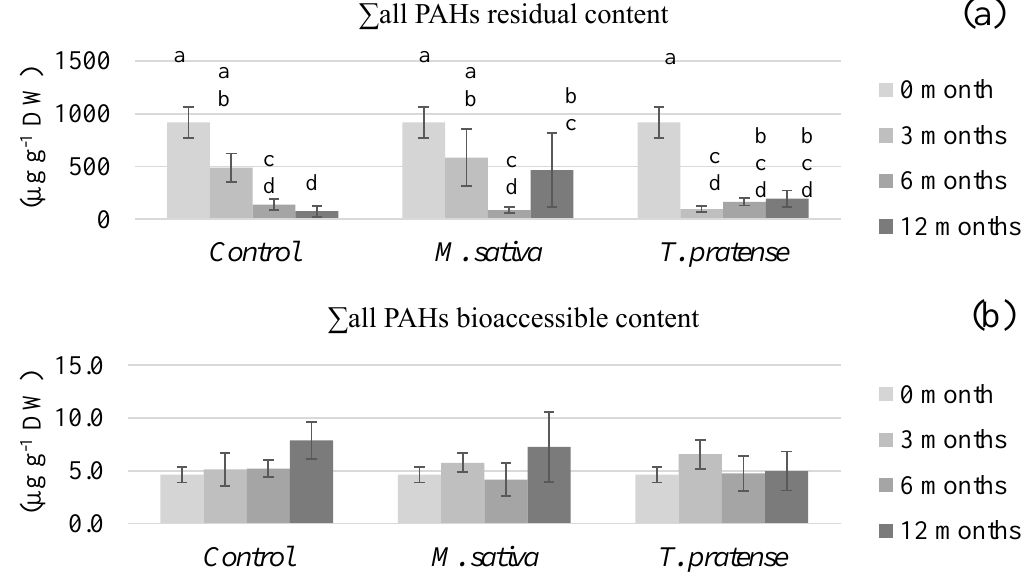
(cid:80) Figure 6. The total PAHs’ ( all) ( a ) residual and ( b ) bioaccessible contents of soils planted with Figure 6. The total PAHs’ (∑all) ( a ) residual and ( b ) bioaccessible contents of soils planted with M.